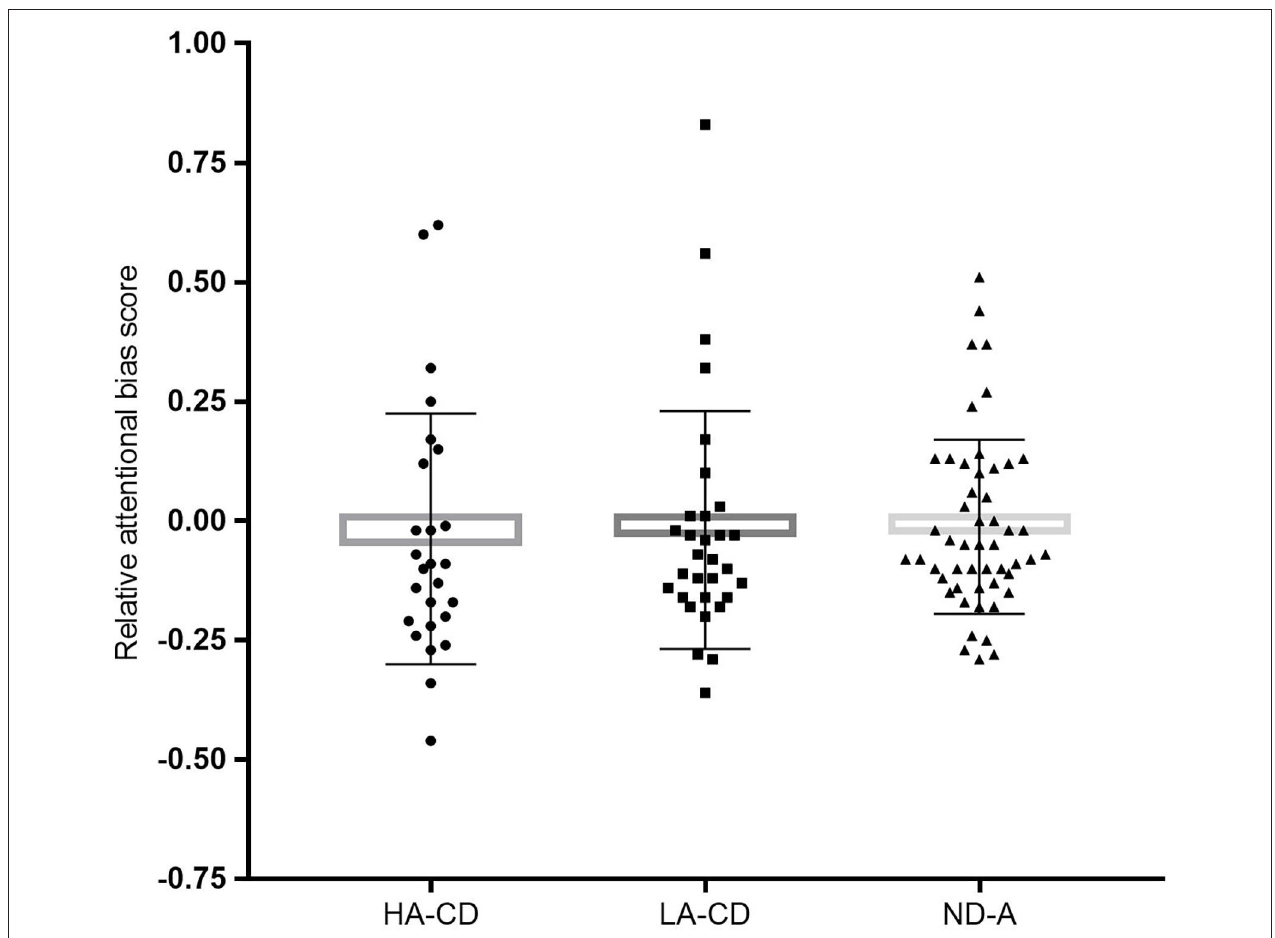
FIGURE 3 | The graph represents the mean relative attentional bias scores for each group with individual data points: HA-CD, high alexithymia currently depressed ( n = 29); LA-CD, low alexithymia currently depressed ( n = 28); ND-A, never depressed controls ( n = 47). Error bars represent standard deviations.